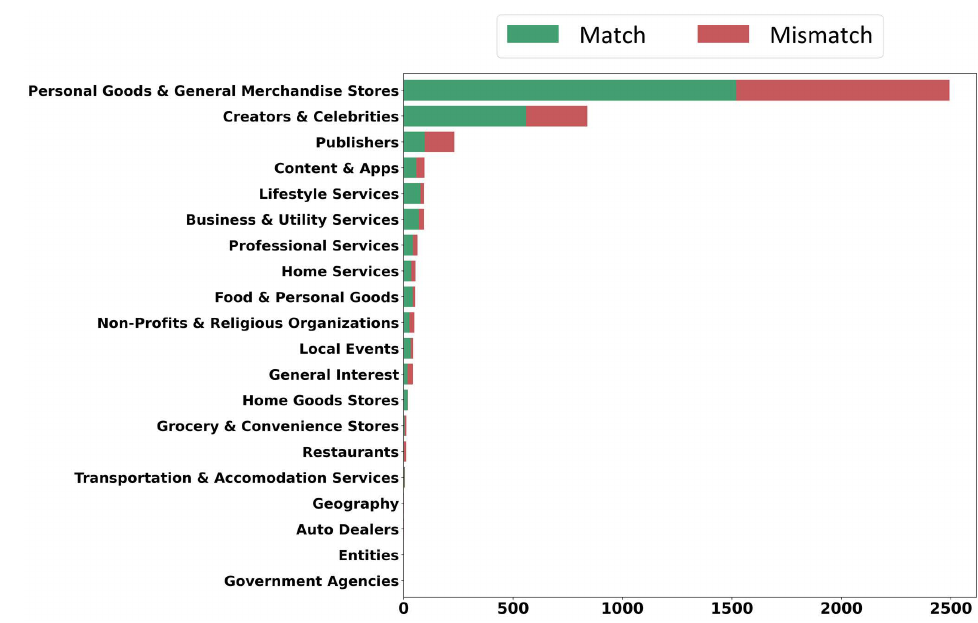
Figure 10. The comparison of business accounts in the dataset.